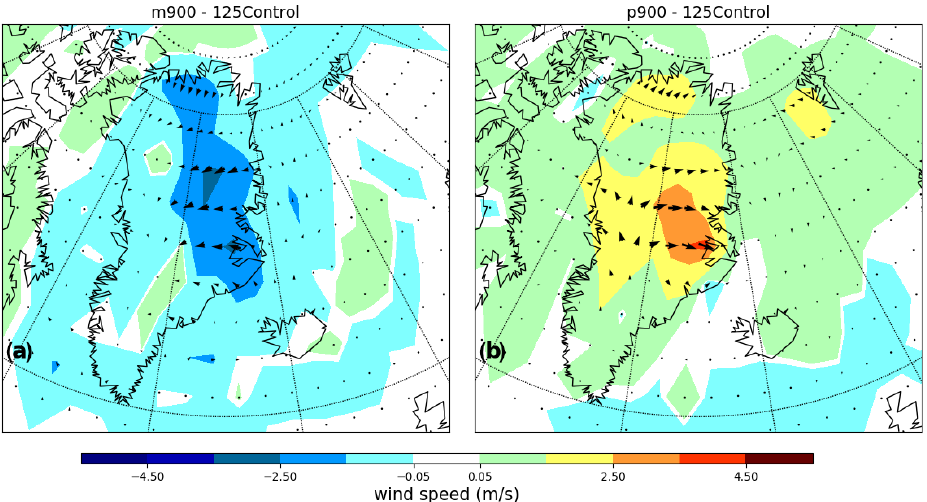
Figure A5. Change in 10m winter (DJF) wind speed (in ms − 1 ) for (a) m900 and (b) p900 compared to 125Control. Only the anomalies statistically significant at the 95% confidence level are